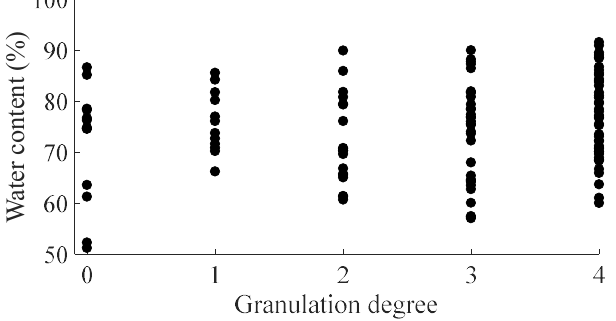
Figure 9. Relationship between the water content (%) and granulation degree of pomelo.